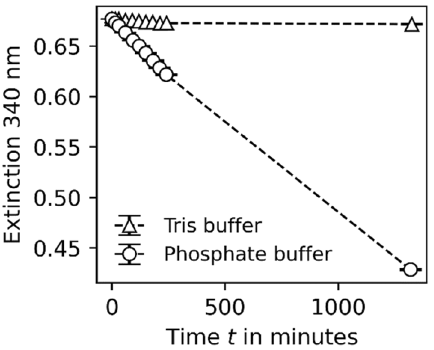
Figure 2. Extinction at 340 nm in the percentage of start extinction over time for 0.1 mM NADH in Tris buffer ( �) and Phosphate buffer (O) (both pH 6.8).